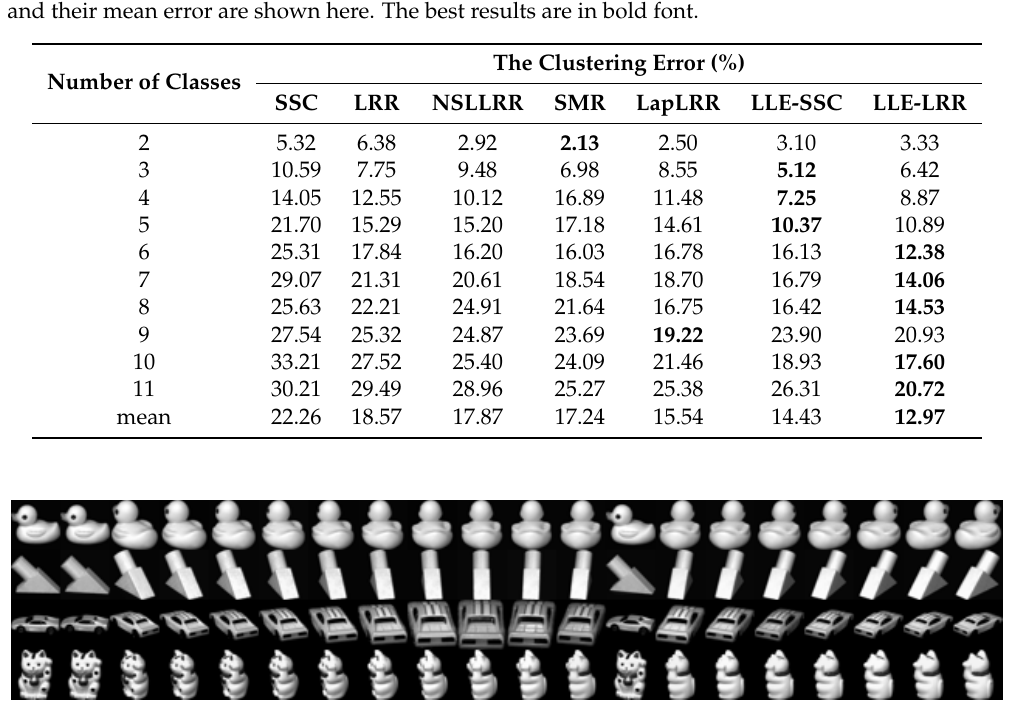
Figure 6. Some object images from the COIL20